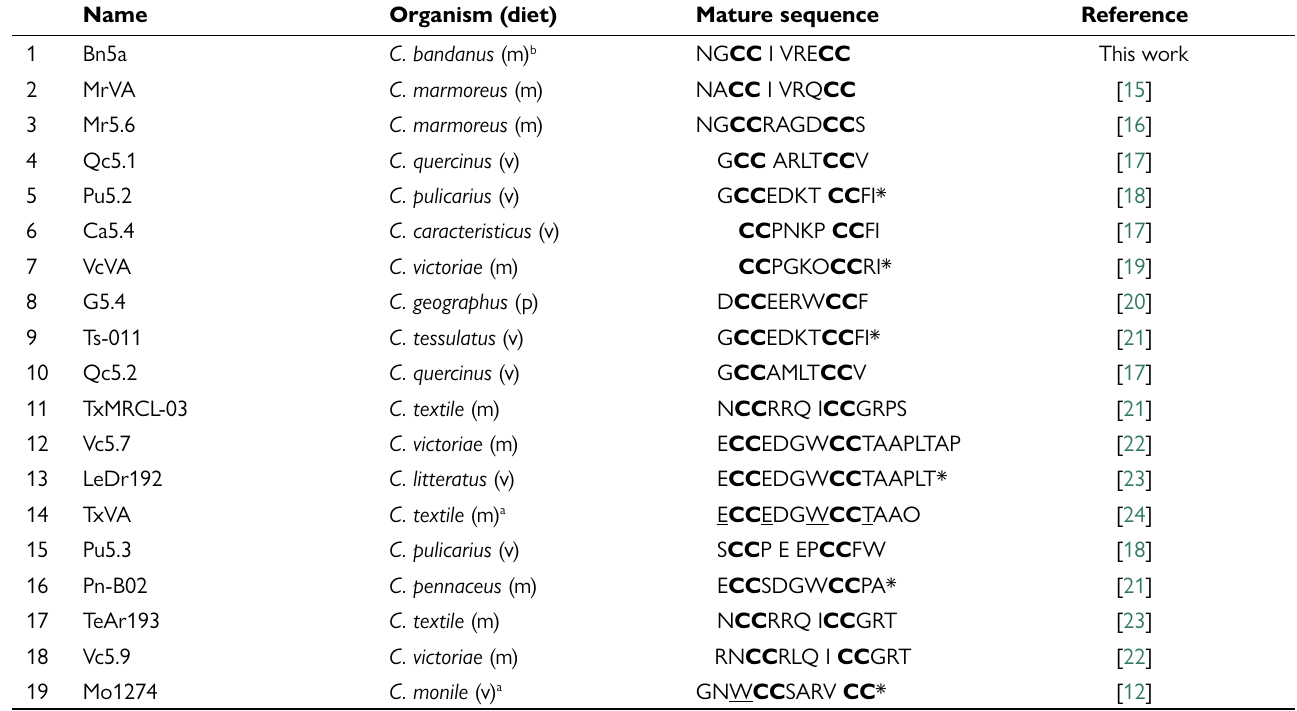
Table 1. T1-subfamily conopeptides, isolated from different Conus species